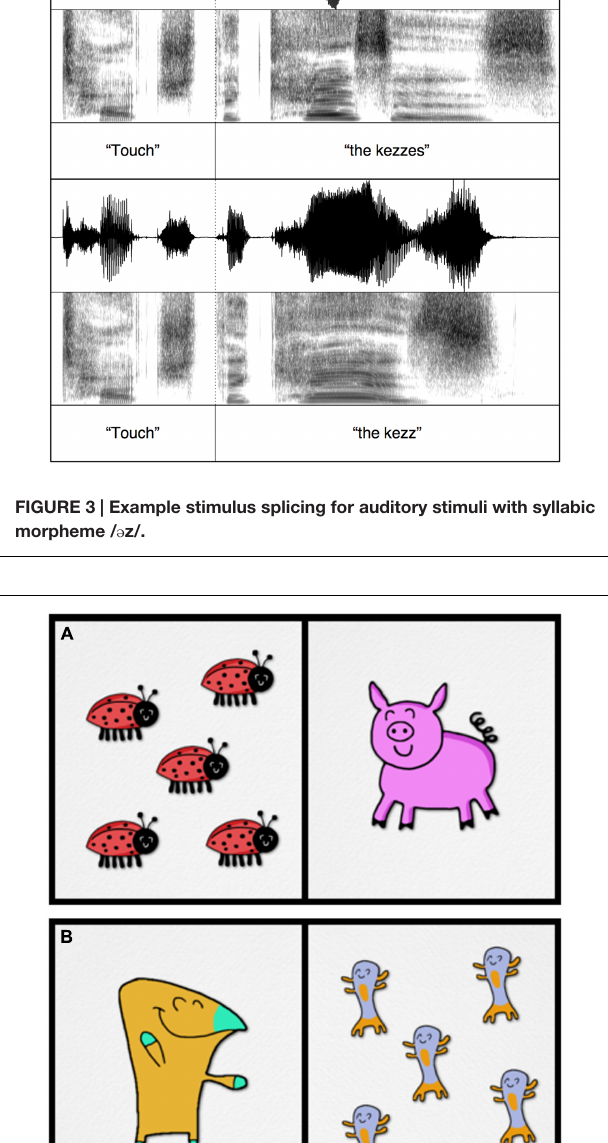
and not lexical knowledge.